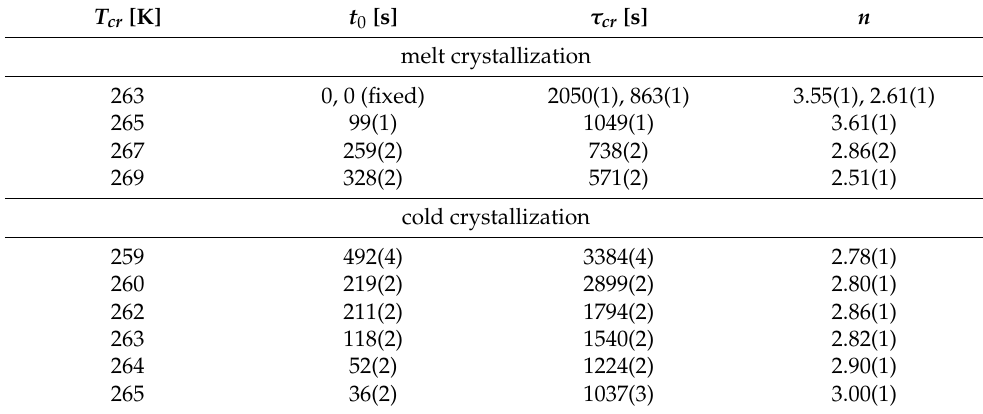
Table 2. Parameters of the Avrami model describing the kinetics of crystallization of